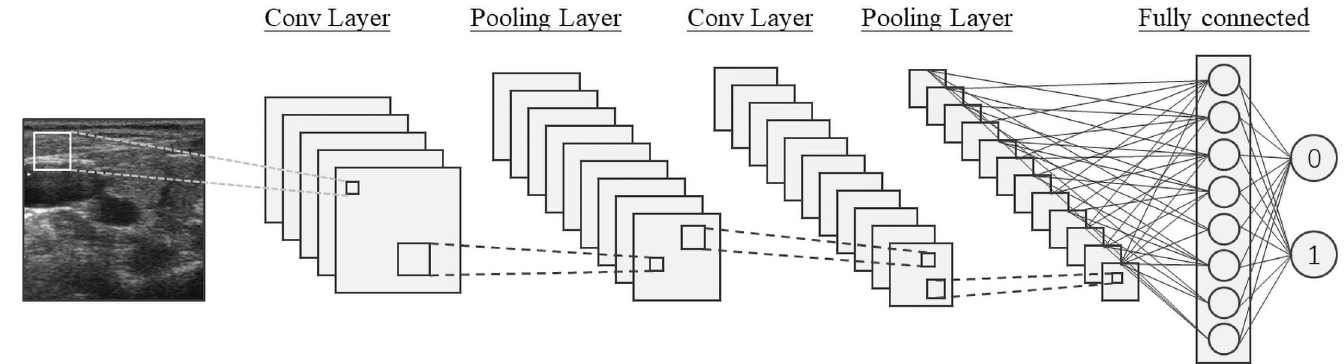
Fig 1. Typical single-channel CNN